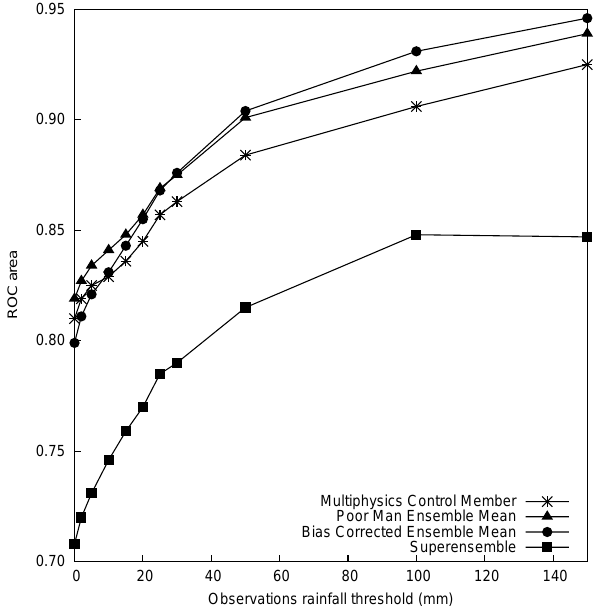
Fig. 1. Geographical domain used for the MM5 numerical simulations. The spatial distribution of the AEMET raingauge network used for the verification procedure is plotted using crosses.